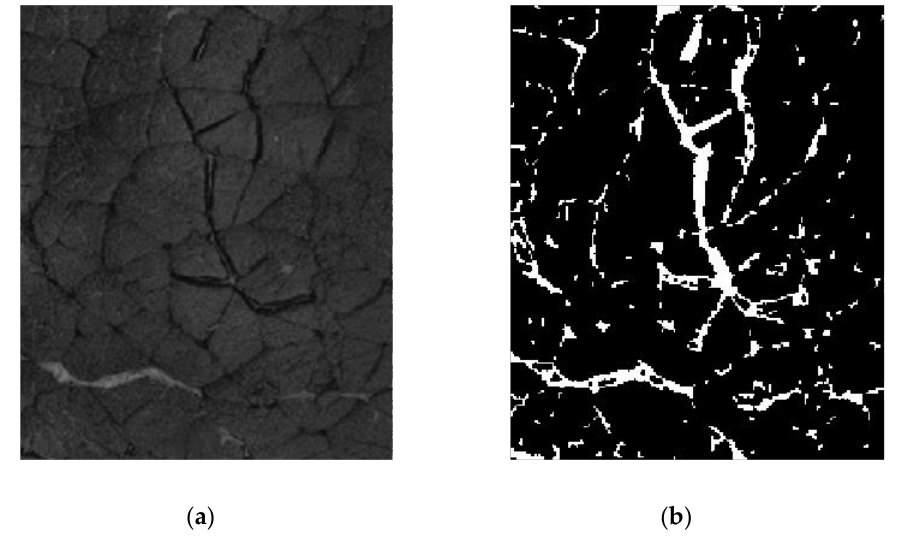
Figure 2. A Biceps femoris multispectral image recorded at 450 nm ( a ) before and ( b ) after the segmentation procedure.